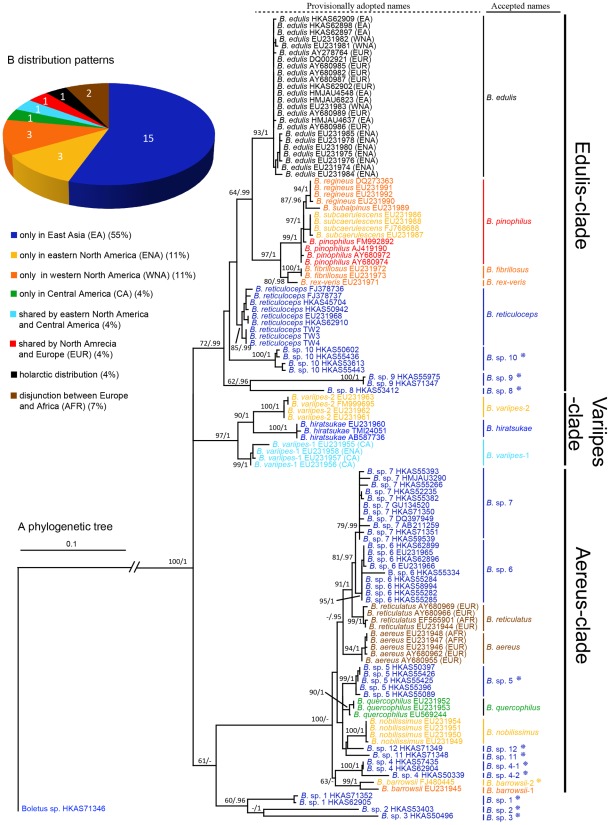
Phylogenetic tree and distribution patterns of the species within the porcini s.s. lineage.Panel A shows the topology inferred from ML analysis using the ITS data. The two values at each node represent the percentage of bootstrap supports (ML)/posterior probabilities (BI). Provisionally adopted names (based on tree topology) and finally accepted names (based on our proposed criterion for phylogenetic species identification) for all taxa are listed. Newly identified phylogenetic species are highlighted by adding asterisks after their names. Three major clades are separately marked with bold lines, and the fourth one is not marked due to its low statistical support values. Panel B lists the distribution patterns of the porcini s.s. as a pie chart. Colors in both panels represent different distribution ranges.